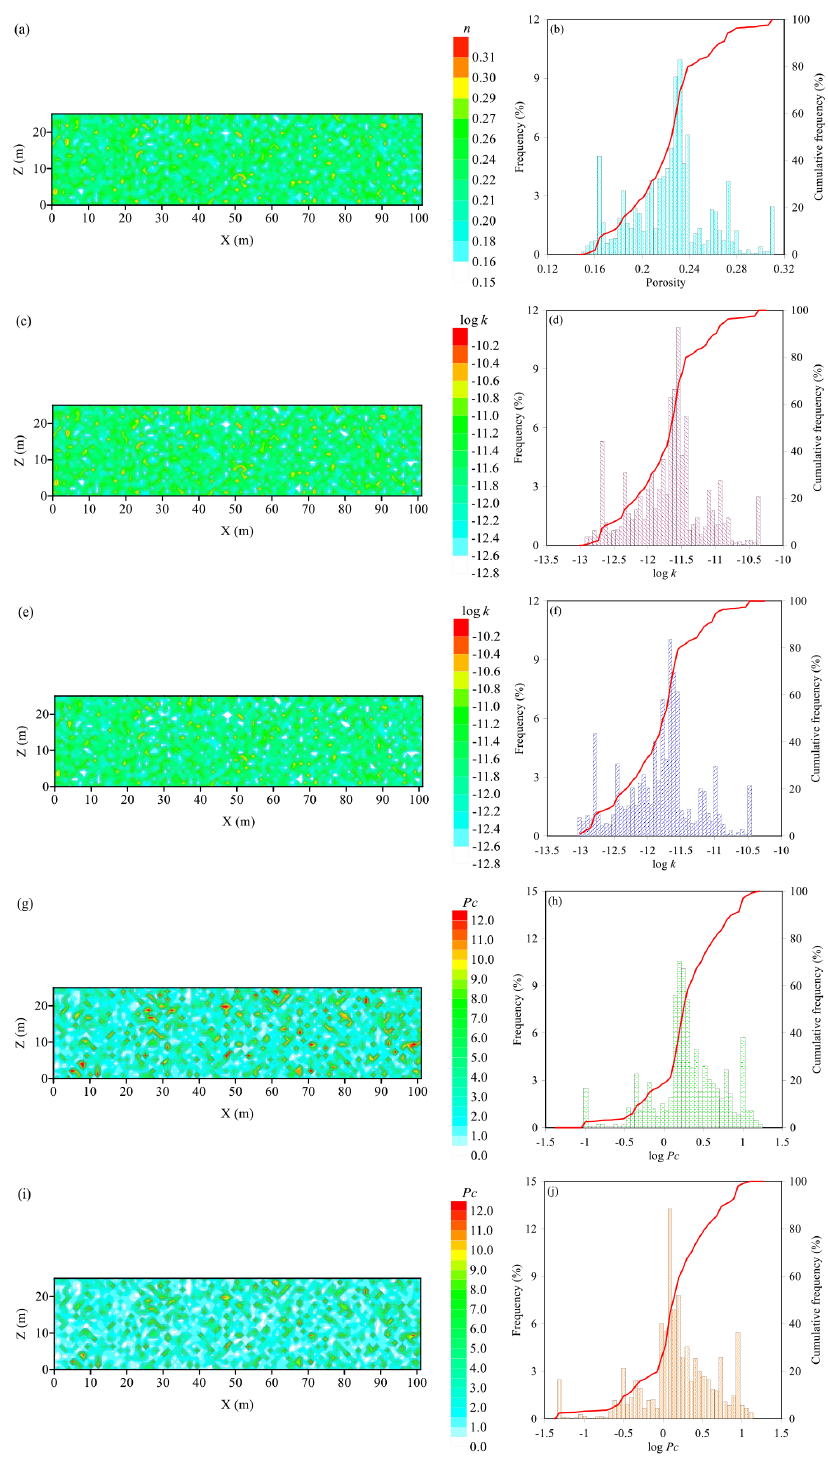
Figure 4. (a) The individual porosity field generated by the sequential Gaussian simulation (SGS) method; (b) the frequency of an individual porosity field; (c) the individual permeability field of RTA obtained from an individual porosity field; (d) the frequency of individual perme- ability field for RTA; (e) the individual permeability field of SPA obtained from an individual porosity field; (f) the frequency of individual permeability field for SPA; (g) the obtained individual entry-pressure field of RTA; (h) the frequency of individual entry-pressure field of RTA; (i) the obtained individual entry-pressure field of SPA; and (j) the frequency of individual entry pressure of